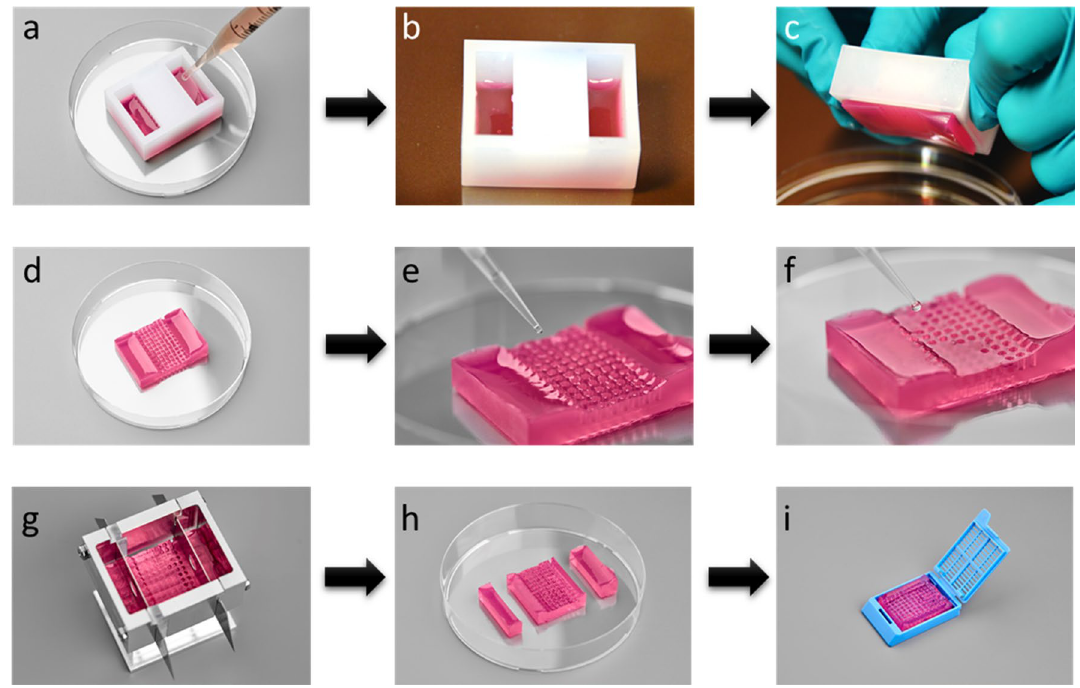
Figure 4. HistoBrick preparation and use. ( a ) Place the silicone mould in a glass petri dish with the pillars facing downwards and fill the mould with the agarose-HistoGel mixture from the side openings, ( b ) The filled mould should then be cooled at 4–5 °C for 2 h, ( c ) Unmold the HistoBrick by pressing the sides, ( d ) Unmolded HistoBrick, ( e ) Load fixed micro-tissues, ( f ) Add HistoGel in the wells and cool at 4–5 °C, ( g ) Cut the block using the slicing tool, ( h ) After dividing the HistoBrick into three segments, the two side segments can be discarded and the central segment containing the wells should be reserved for histological processing, ( i ) Place the central segment of HistoBrick in a histology